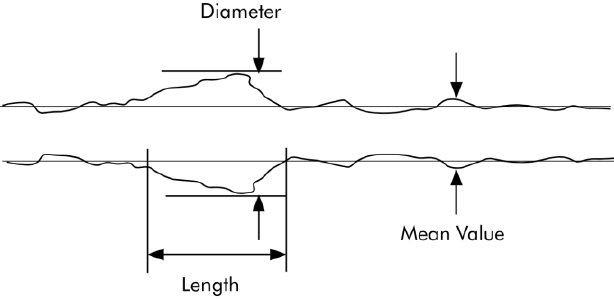
Figure 10. Textile yarn configuration (Adapted from [14]).